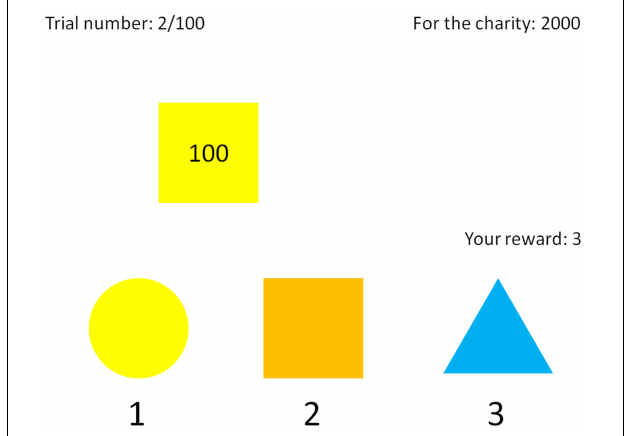
FIGURE 1 | An illustration of a computer screen seen by a participant. The top row shows information about the number of the current trial, the total number of trials, and the number of points currently assigned to the charity organization. In the middle of the screen, an object (a yellow square in this case) is moving from the left side of the screen to the right. The current participant’s reward in points is shown to the right of the screen. In the bottom row, a participant sees which shapes and colors are assigned to keys “1,” “2,” and “3” in this trial (in this example, 1 is yellow circle, 2 is orange square, and 3 is blue triangle). If the participant presses “1,” the object would be sorted by its color, that is correctly, and the participant would gain 3 points. If the participant presses “2,” the object would be matched to a wrong color, and would cause a loss of 200 points for the charity, but it would be sorted according to its shape, allowing the participant to gain the 100 points marked on the object in addition to the 3 points awarded for each sorted